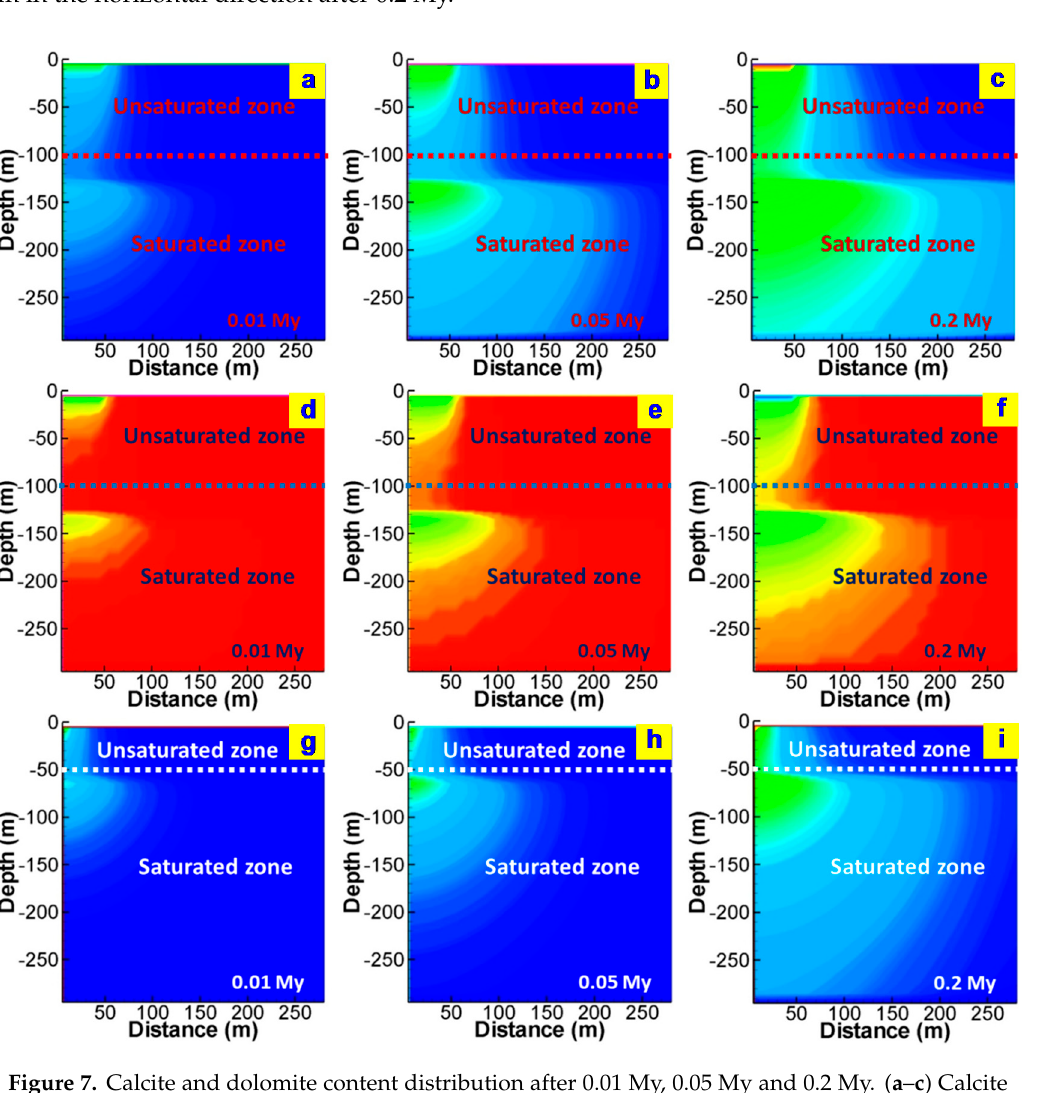
Figure 6. Porosity evolution in each model (Case 2–Case 13).